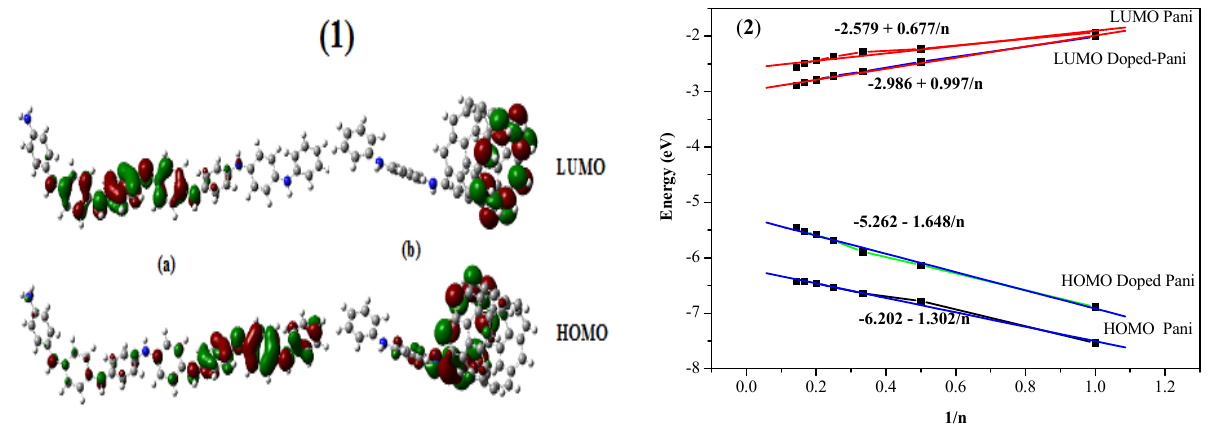
Figure 15. ( 1 ) HOMO and LUMO orbitals: doped PANI ( a ) and nanocomposite ( b ). ( 2 ) Effect of chain length on the HOMO–LUMO energy levels of PANI in pristine and doped states.